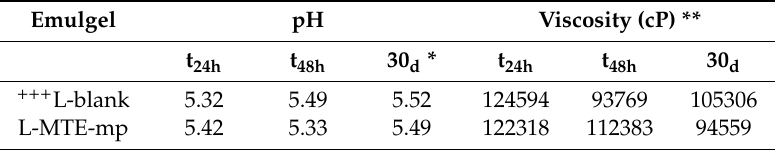
Table 2. pH and viscosity values of emulgels produced with